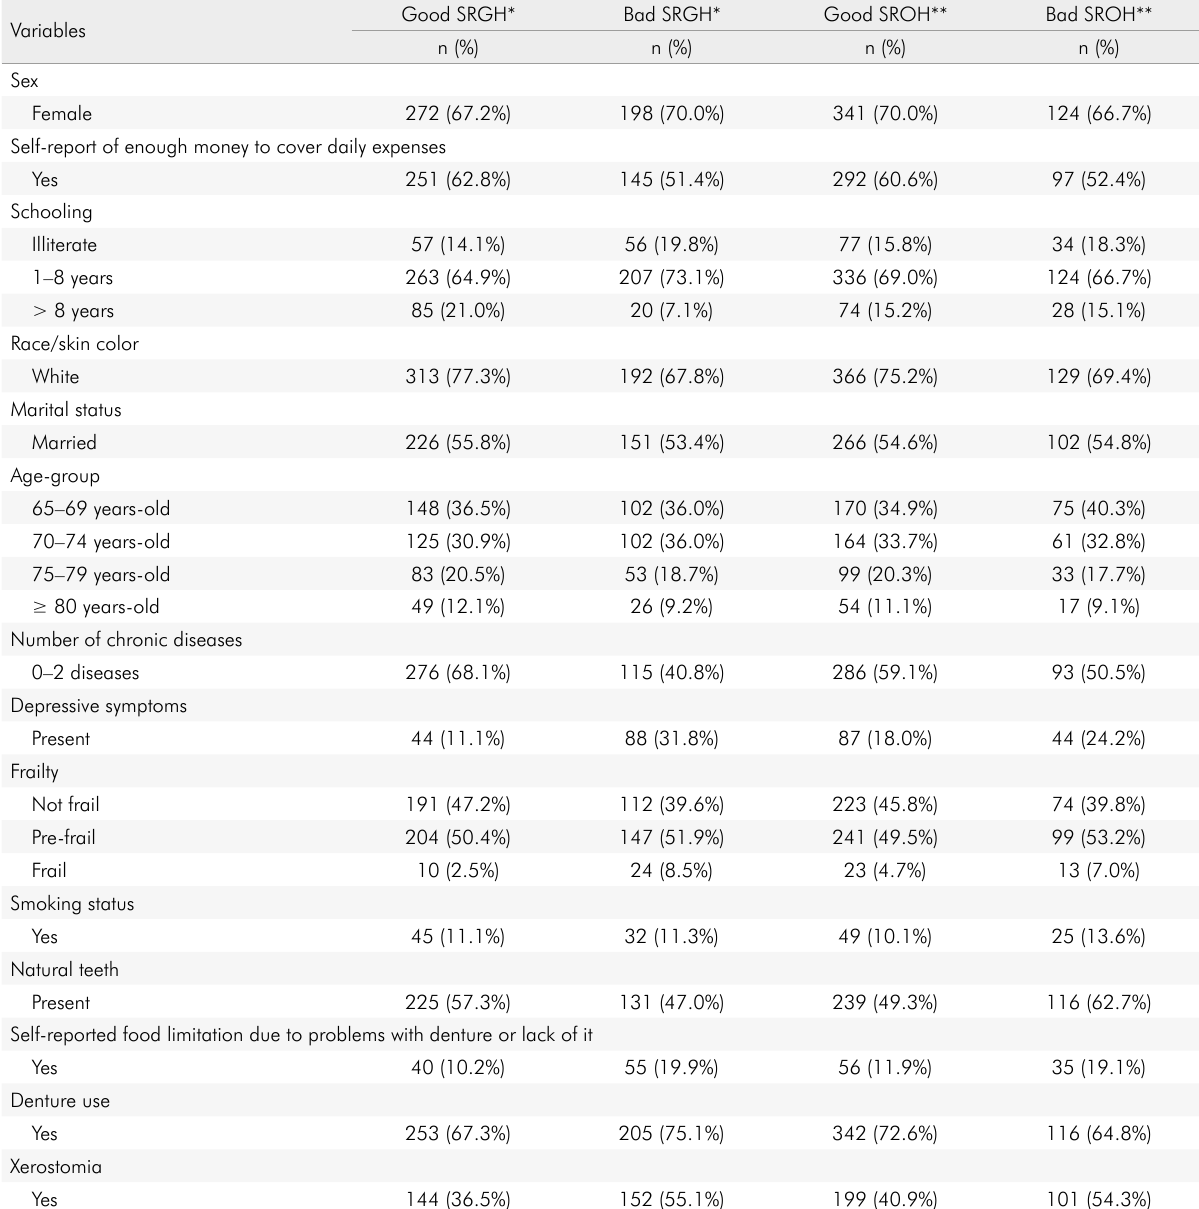
Table 1. Socio-demographic, personal, general, and oral health characteristics and frequency distributions of study sample according to the outcomes SRGH (n = 688) and SROH (n =